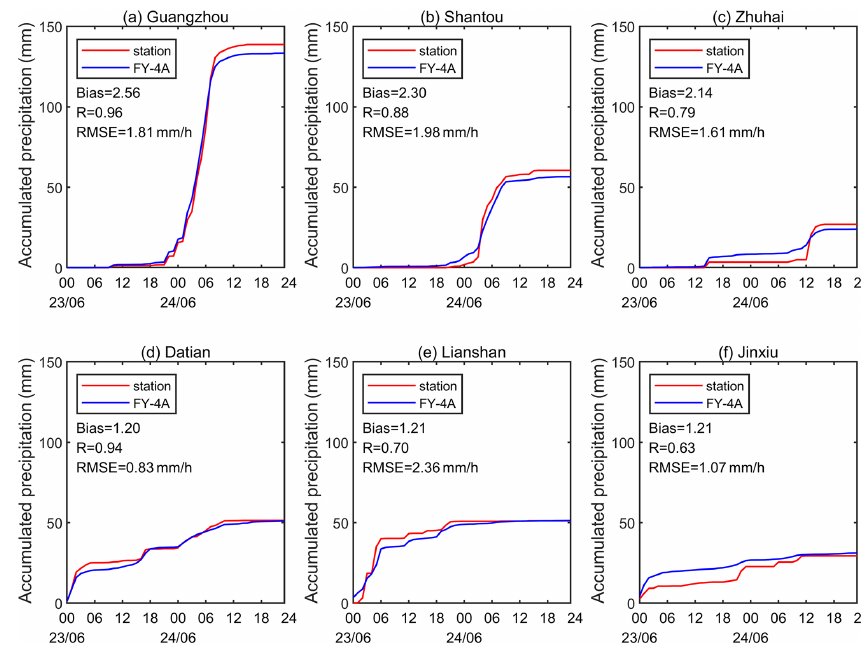
Figure 9. Accumulated precipitation in different areas: (a–c) city stations; (d–f) rural stations.